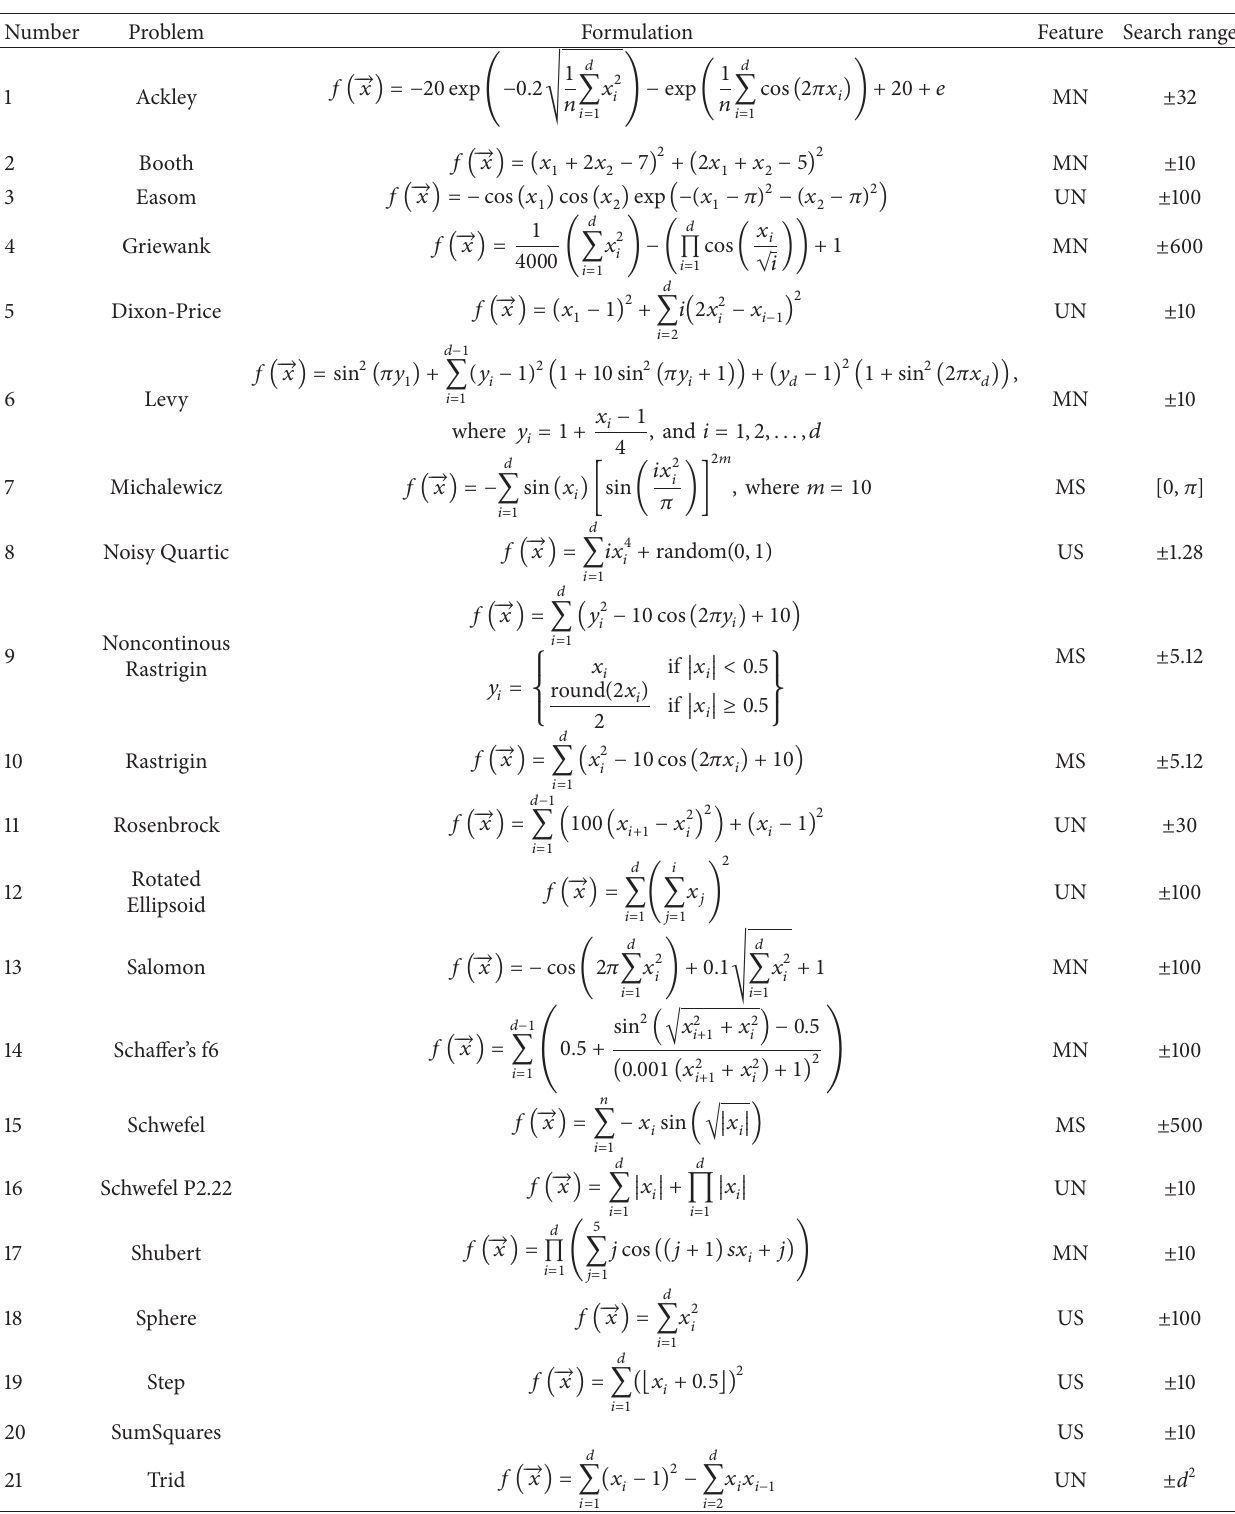
Table 3: Benchmark